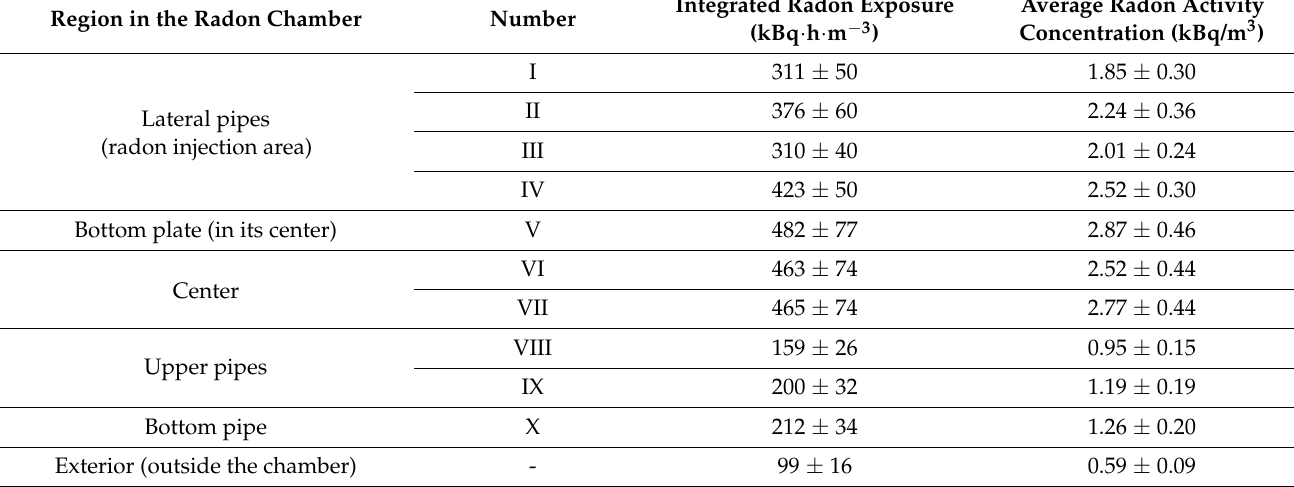
Table 4. Experimental results of the time integrated radon activity concentration obtained with different TASTRAK detectors (all the reported uncertainty values correspond to k =